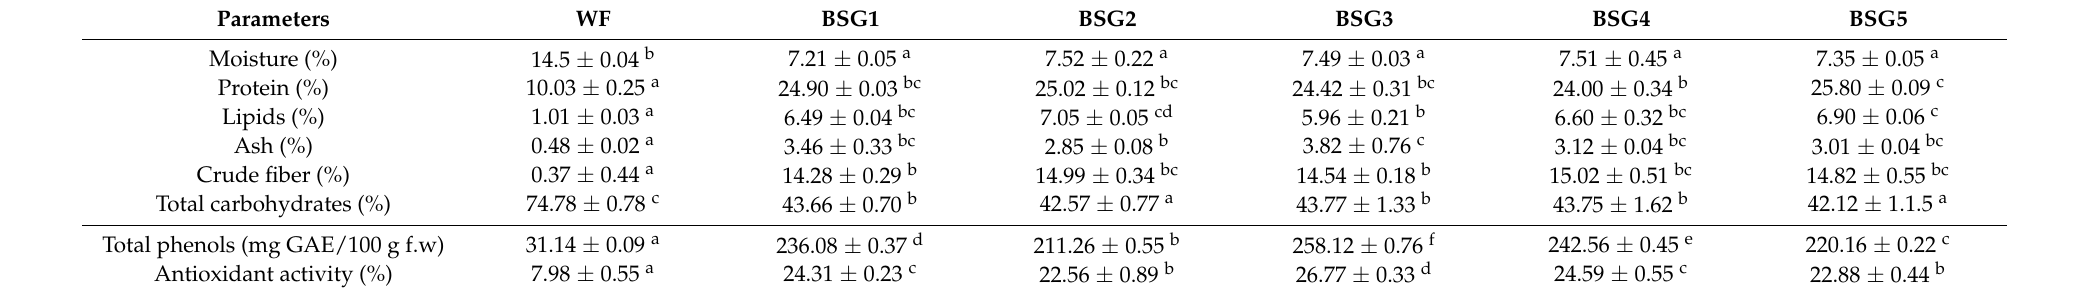
Table 1. Proximate composition of dried BGS (brewers spent grains) samples and WF (wheat